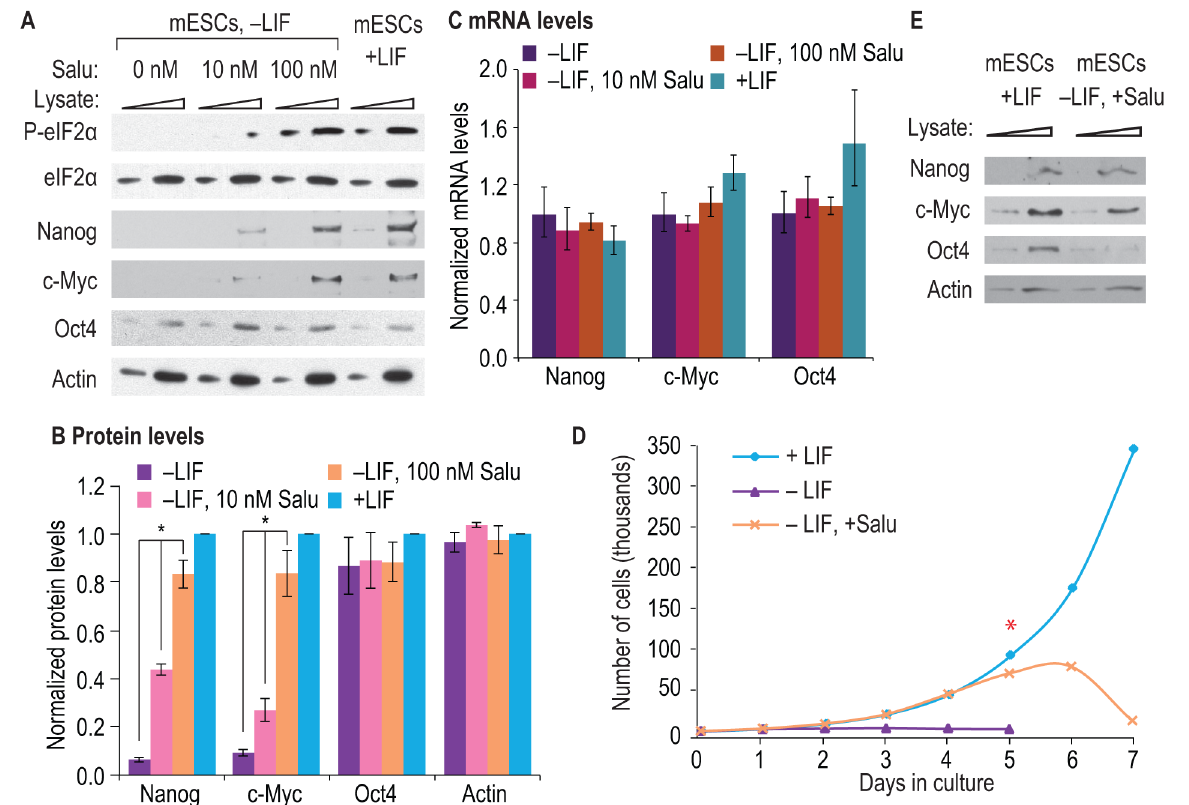
Fig 4. Salubrinal, a CReP inhibitor, prolongs Nanog and c-Myc expression. ( A) mESCs were cultured as in Fig 3 with addition of salubrinal at 0 nM, 10 nM and 100 nM to mESCs cultured without LIF. Increasing amounts of cell lysate (indicated by triangles) were separated by SDS-PAGE and western blotted for indicated proteins. Treatment with salubrinal (Salu) increased the abundance of P-eIF2 α , but had no effect on total eIF2 α ; salubrinal treatment also increased Nanog and c-Myc protein levels, but not Oct4 or Actin. (B) Three biological replicates were prepared as in (A) and quantitated. Data were then normalized to values from mESCs grown with LIF. Error bars represent s.d. ( * , p < 0.01). (C) RNA was prepared from mouse ESCs cultured as in (A) and RT-qPCR used to assay abundance of indicated RNAs. All data were normalized to a control probe set (eEF1A mRNA) and mESCs grown with LIF. Nanog, c-Myc and Oct4 mRNA levels were unaltered in mESCs grown in various combinations of LIF and salubrinal (Salu). Error bars represent s.d. ( * , p < 0.01 compared to mESCs – LIF samples). (D) Mouse ESCs were cultured with LIF (+LIF), without LIF ( – LIF) or without LIF but with salubrinal ( – LIF, +Salu) over several days. Cell numbers were counted on each day of culture. Mouse ESCs grown with LIF continued to divide (aqua line), whereas mESCs cultured without LIF ( – LIF) rapidly stop dividing (purple line). Mouse ESCs cultured without LIF, but with salubrinal ( – LIF, +Salu) (orange line) divided normally for several days but then senesced with the appearance of cell corpses suggesting apoptosis. (E) Mouse ESCs were cultured with LIF or without LIF, but with 100 nM salubrinal, for 5 days. Increasing amounts of cell lysate (indicated by triangles) was separated by 4 – 12% gradient SDS-PAGE and western blotted for indicated proteins. Nanog, c-Myc and Oct4 were all present in mESCs cultured with LIF. In mESCs cultured without LIF, but with added salubrinal, Nanog and c-Myc proteins were expressed at similar levels as in mESCs cultured in LIF. Oct4 levels were higher in mESCs cultured with LIF compared to mESCs cultured without LIF but with salubrinal. Actin was probed as a loading control. Therefore, salubrinal is sufficient to maintain Nanog and c-Myc protein expression, but cannot preserve Oct4